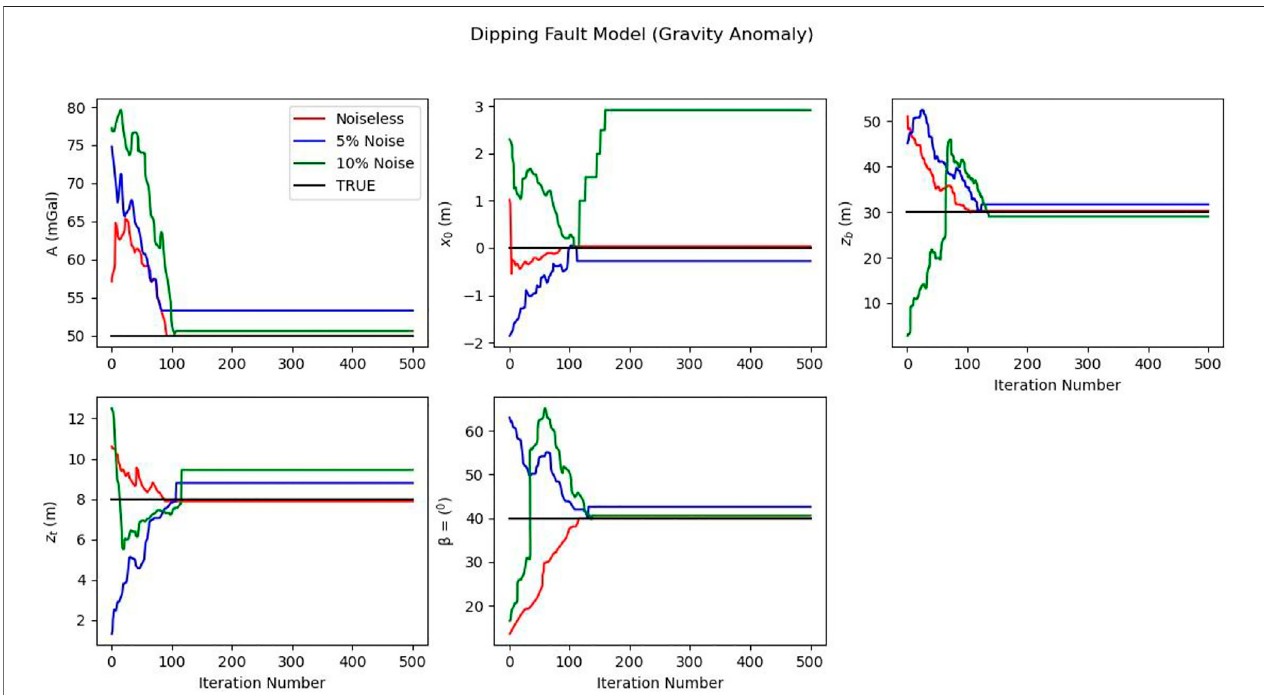
FIGURE 10 | Change in model parameters with iteration (Gravity Anomaly).